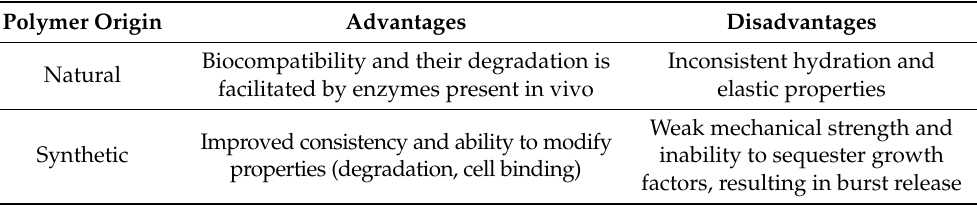
Table 1. Table 1 . Hydrogels: Advantages and